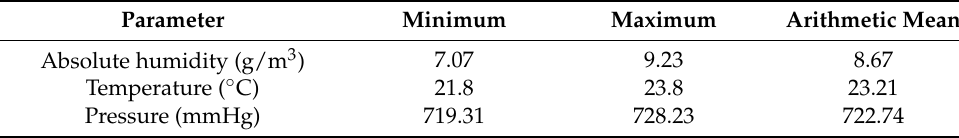
Table 1. Measured ambient conditions for breakdown experiments in less uniform electric